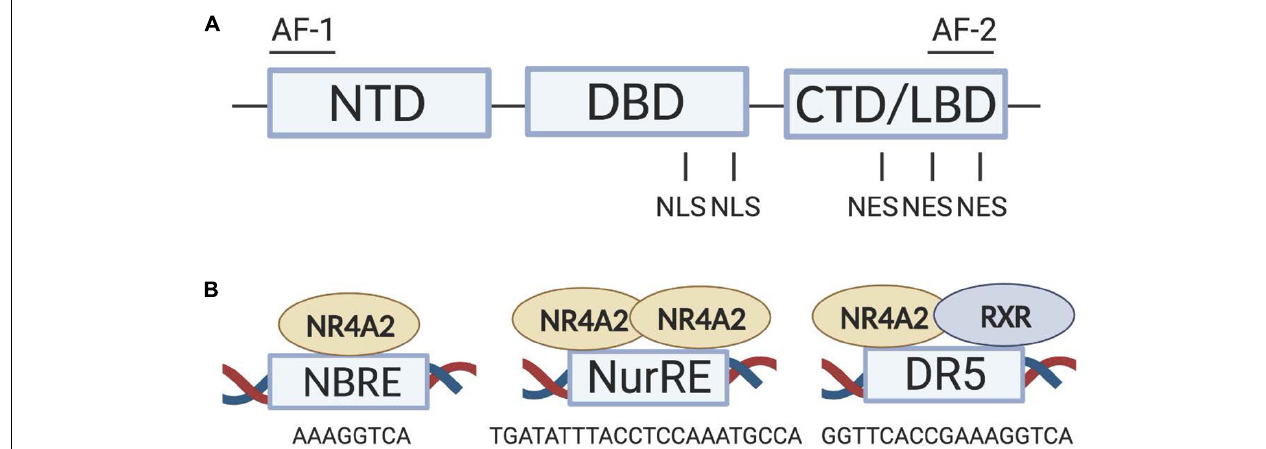
FIGURE 1 | Nr4a2 structure and binding to target genes. (A) Structural domains of Nr4a2, which include NTD, DBD and LBD. Modulator domains (AF-1 and AF-2) and localization signals (NLS and NES) are also depicted. (B) Nr4a2 DNA-binding sites as monomers at NBRE sites, as dimers (homodimers or heterodimers, not shown) at NurRE sites and as heterodimers with RXR at DR5 sites. AF, activation function; CTD, C-terminal domain; DBD, DNA-binding domain; LBD, ligand-binding domain, NBRE, nerve growth factor-inducible- β -binding response element; NES, nuclear export signal; NLS, nuclear localization signal, NTD, N-terminal domain; NurRE, nur-response element; RXR, retinoic X